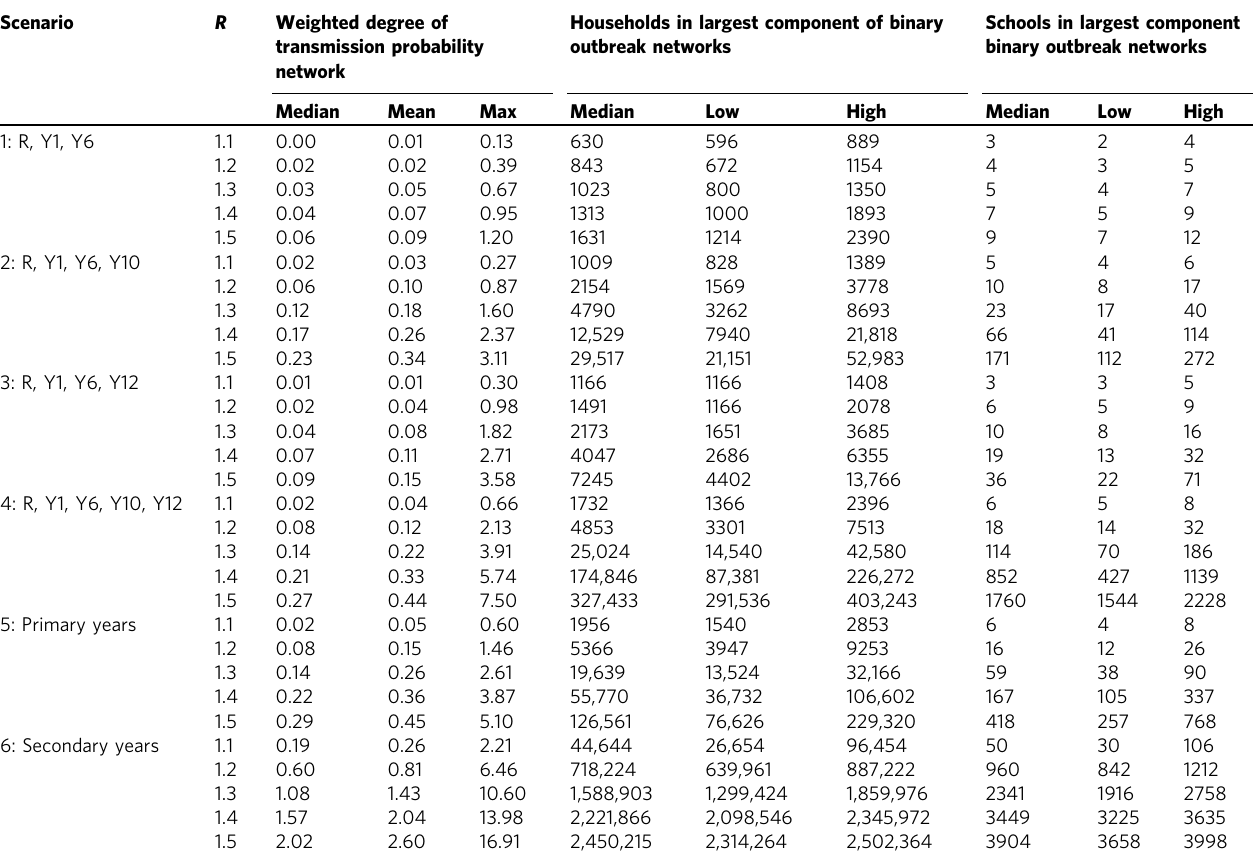
Table 2 Weighted degree of the transmission network and largest components of the binary outbreak networks. Scenario R Weighted degree of transmission probability